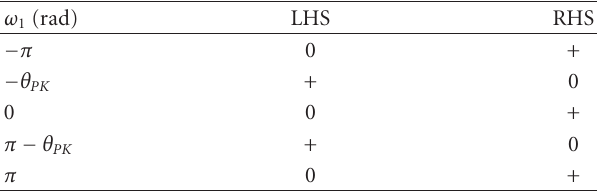
Table 2: Partitioning of search domain of ω 1 in (21). ω 1 (rad) LHS − π